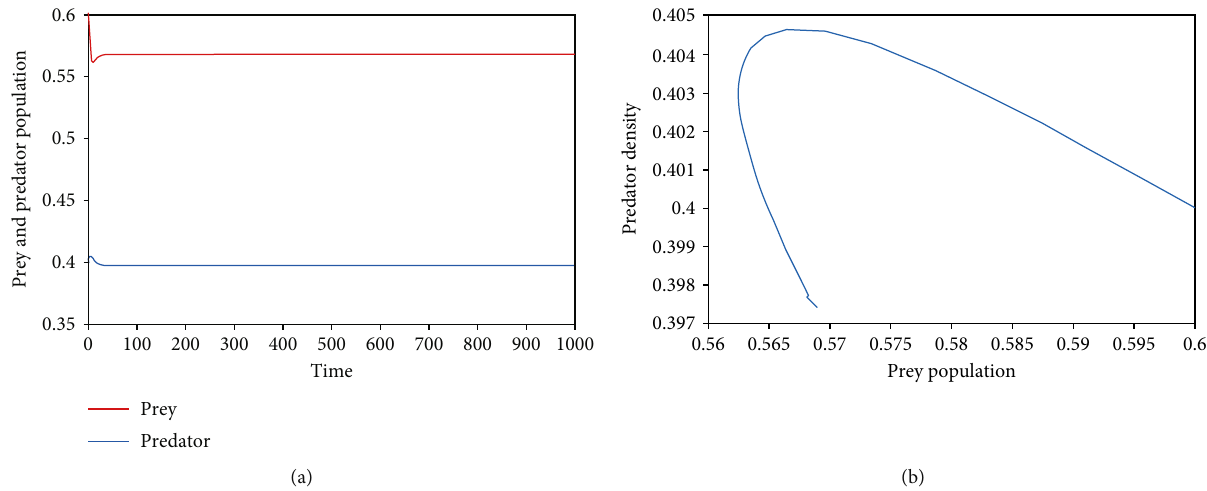
2 with parametric value as in Table 2